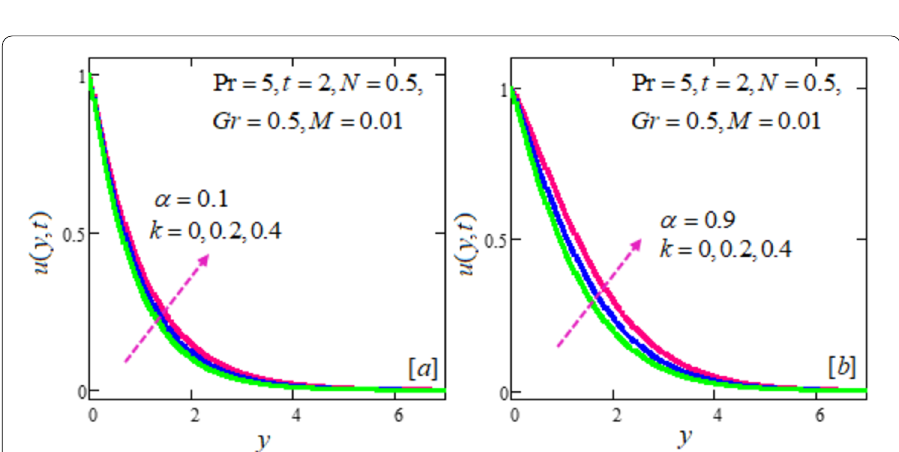
Figure 5 Velocity profile variation with Grashof number Gr and fractional parameter α